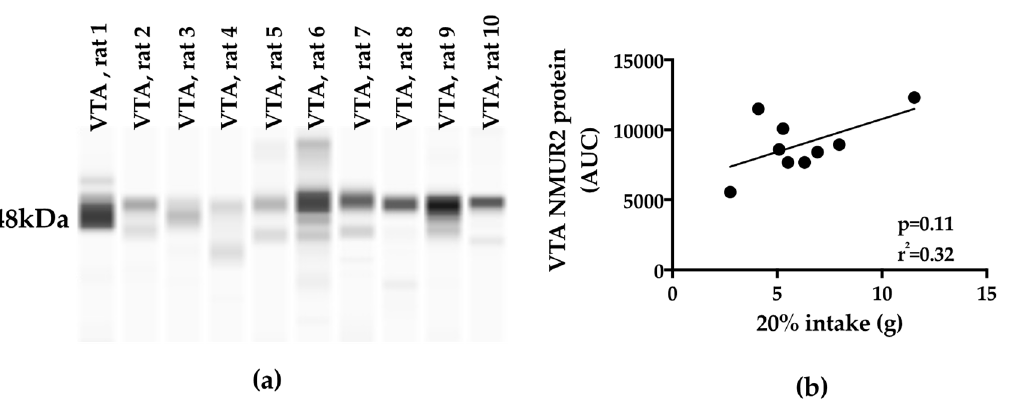
Figure 4. VTA NMUR2 protein expression was negatively correlated with binge-type eating. ( a ) representative Western blot image for NMUR2 synaptosomal protein from VTA samples; ( b ) VTA NMUR2 expression was not correlated with intake of a 20% fat (80% carbohydrate) mixture; ( c ) VTA NMUR2 expression was not correlated with intake of a 40% fat (60% carbohydrate) mixture; ( d ) VTA NMUR2 expression was not correlated with intake of a 60% fat (40% carbohydrate) mixture; ( e ) VTA NMUR2 expression was not correlated with intake of an 80% fat (20% carbohydrate) mixture; ( f ) VTA NMUR2 expression was negatively correlated with intake of a 100% fat (0% carbohydrate) mixture. * p < 0.05. 4. Discussion In the present study, we assessed the synaptic localization of NMUR2 in the NAc and the VTA. Our results support previous studies indicating synaptic NMUR2 expression in the NAc. Additionally, these results extend our knowledge by demonstrating Western blot staining of NMUR2 in synaptosomal VTA fractions, and by visualizing punctate staining patterns for NMUR2 in the VTA, consistent with synaptic localization [46]. Our NMUR2 antibody has previously been shown to stain NMUR2-expressing cell bodies in the PVN, suggesting that the staining pattern is not